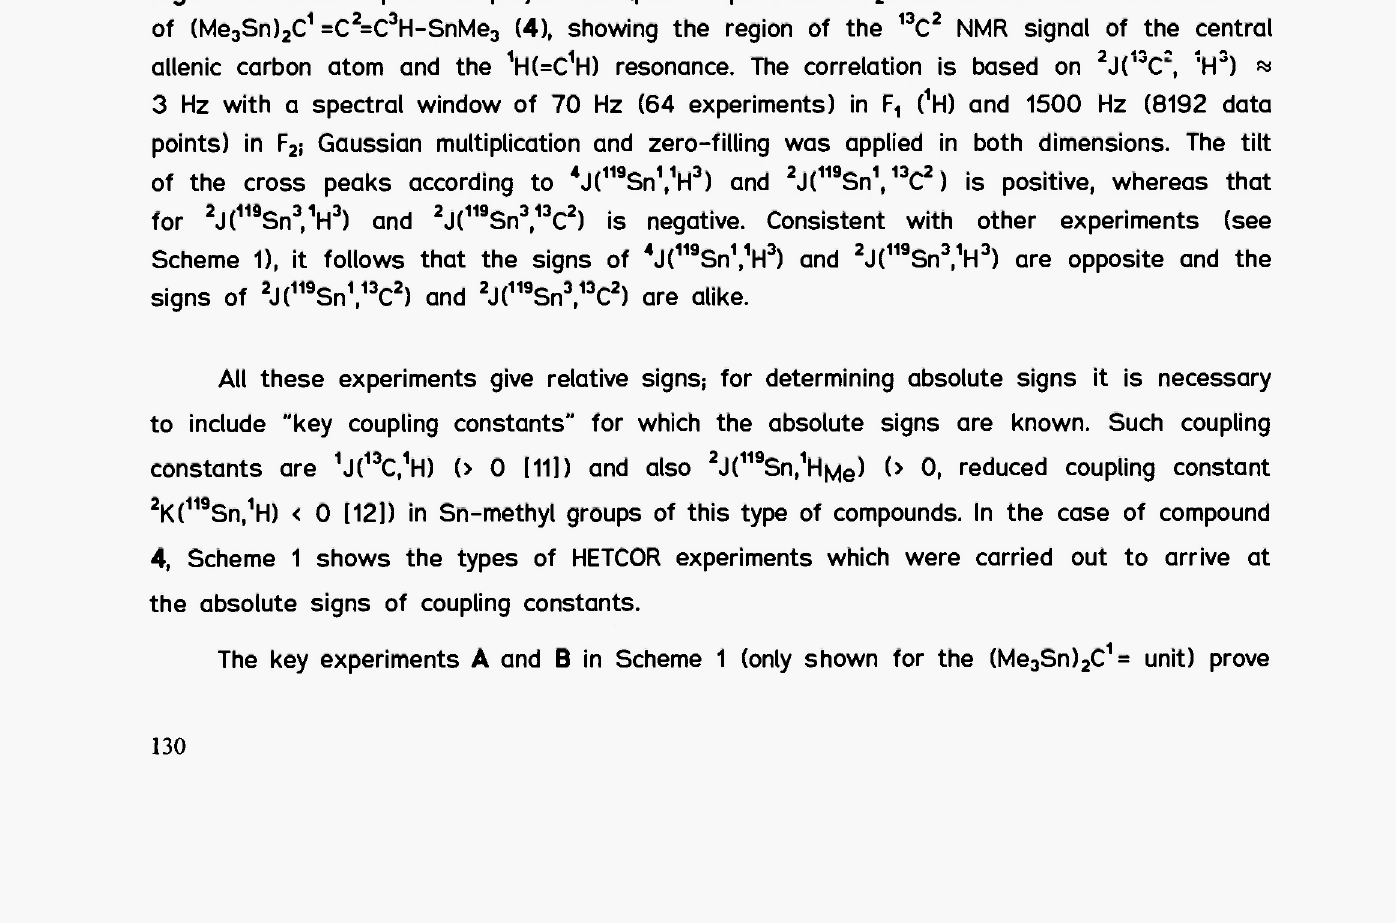
Figure 1. Contour plot and projections (power spectrum in F 2 ( 13 C)) of the 2D 13 C/ 1 H HETCOR of (Me 3 Sn) 2 C 1 =C 2 =C 3 H-SnMe 3 (4), showing the region of the 13 C 2 NMR signal of the central 4